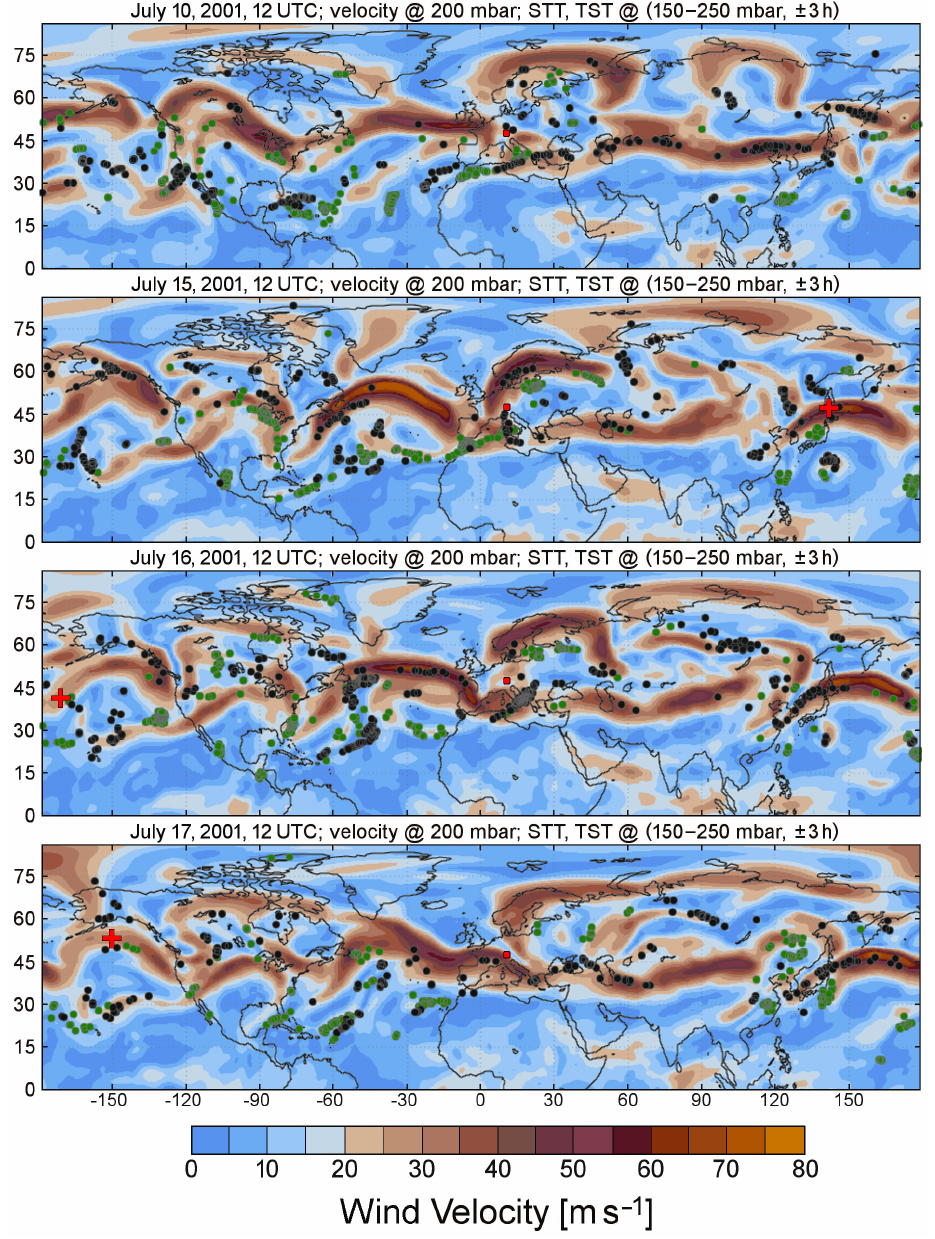
Fig. 19. Selected examples of the ECMWF/LAGRANTO visualizations of the jet streams for Case 5; the position of Garmisch-Partenkirchen is marked with a red dot next to the centre of each panel. The mean single-day position of the uppermost FLEXPART cluster is marked with a red cross for the days corresponding to panels 2 to 4. The wind speed is colour coded. The positions where trajectories revealed STT or TST between 150 and 200mbar are marked by green and black dots, respectively.